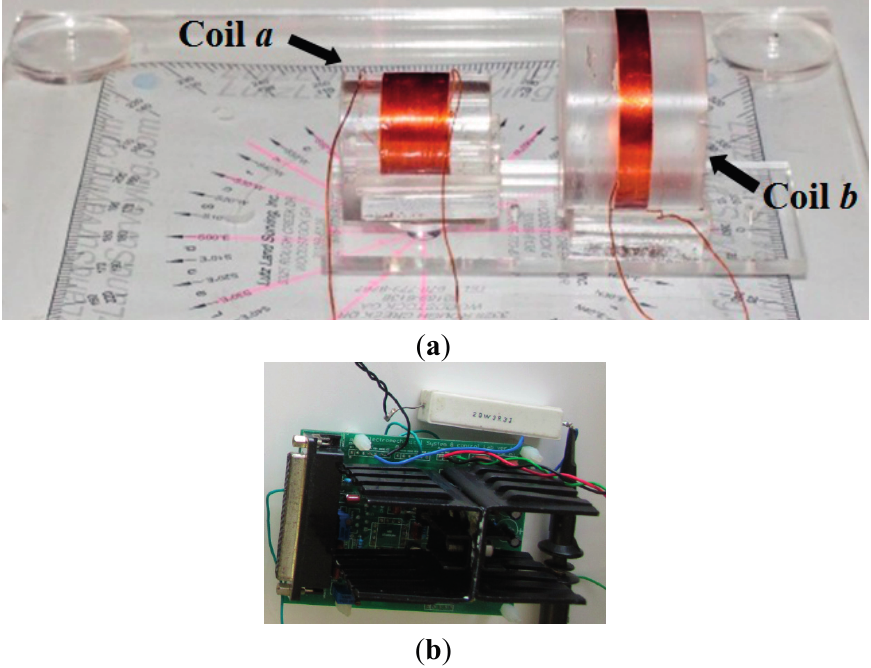
Figure 13. Coil designs: ( a ) coil 1 (